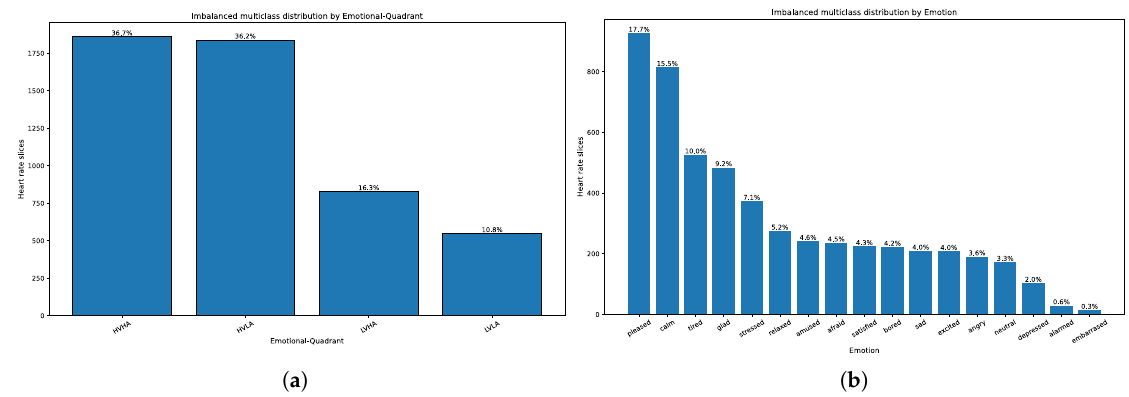
Figure 2. Physiological dataset with a distribution of classes: ( a ) by emotional quadrants; ( b ) by a ff ective